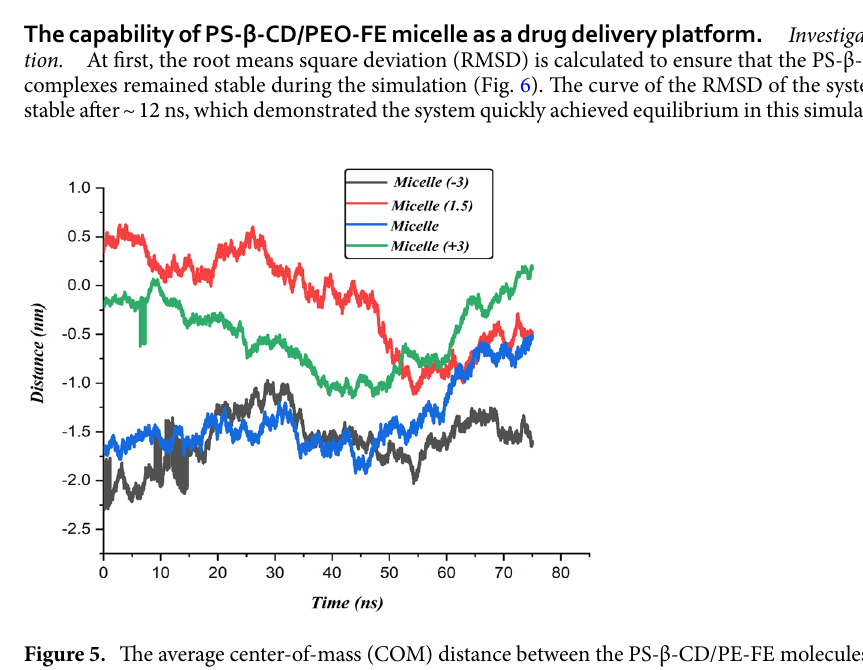
Figure 5. The average center-of-mass (COM) distance between the PS-β-CD/PE-FE molecules during of simulation.